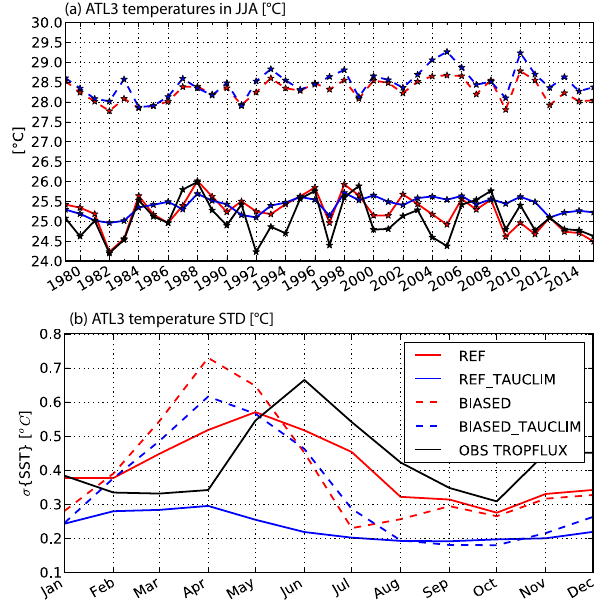
Figure 2. (a) Time series of the Atl3 index (SST averaged in JJA between 20 ◦ W–0 ◦ N and 3 ◦ S–3 ◦ N) obtained from TropFlux and simulations. Monthly standard deviation of Atl3 SST using data from 1979 to 2015. Units are degrees